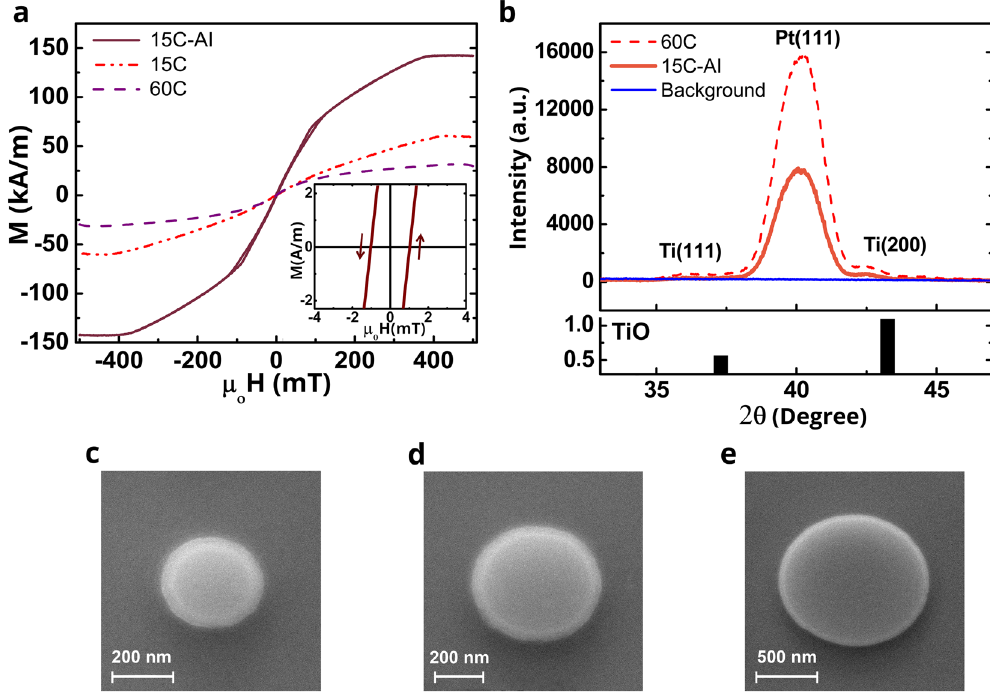
Figure 3. In-plane external field VSM, XRD, MFM and SEM measurements ( a ) Room temperature VSM measurements with in-plane external magnetic field for samples 15 C (red dash-dotted line), 15C-AI (brown- red solid line) and 60 C (purple dashed line). The inset shows the zoomed in version for sample 15C-AI, the only one showing hysteresis. The arrows indicate the field scan direction. ( b ) XRD data for samples 15C-AI (orange solid line) and 60 C (red dashed line) are shown along with Si/SiO 2 substrate data as background (blue solid line). The crystal orientations corresponding to the diffraction peaks are identified as being due to Pt 21 and Ti that gets progressively oxidized to TiO thin films suggesting a strong < 111 > texture. For reference JCPDS card data of TiO is included 22 . ( c – e ) Scanning Electron Microscopy (SEM) images of nano disk with various diameters, ( c ) 300 nm ( d ) 500 nm and ( e ) 1200